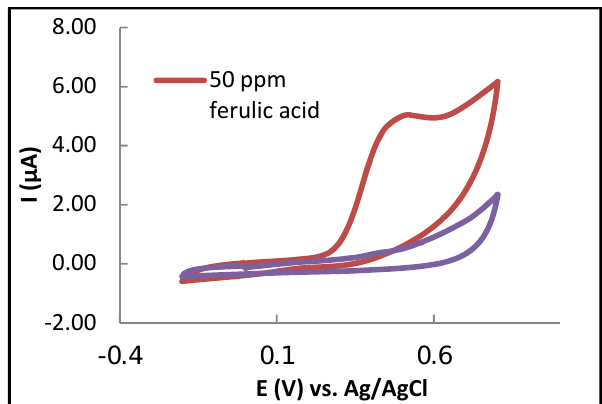
Figure 2. Cyclic voltammogram of 50 ppm ferulic acid in 0.1 M acetate buffer solution (pH 5). Scan rate 100 mV/s, electrode area 0.8 cm 2 . Voltammograms shown are representative of at least five independent repetitions.